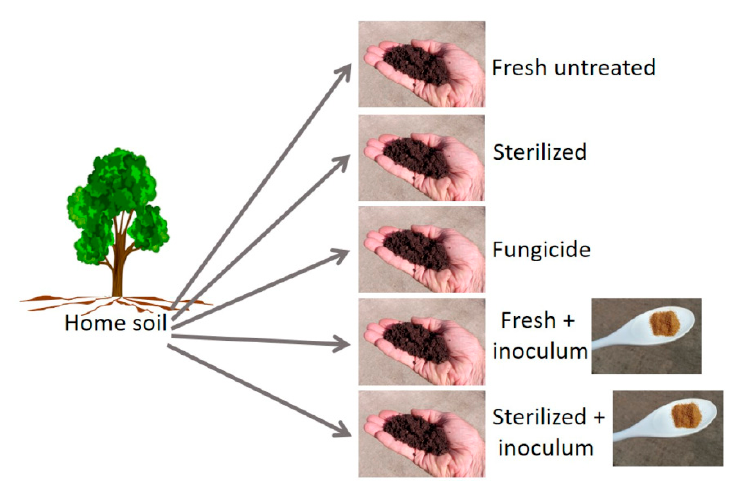
Figure 3. Manipulation of Serianthes rhizosphere soils with five treatments. Sterilized soil treated with 121 °C. Fungicide treatment was propiconazole. The inoculum was Rhizophagus irregularis.